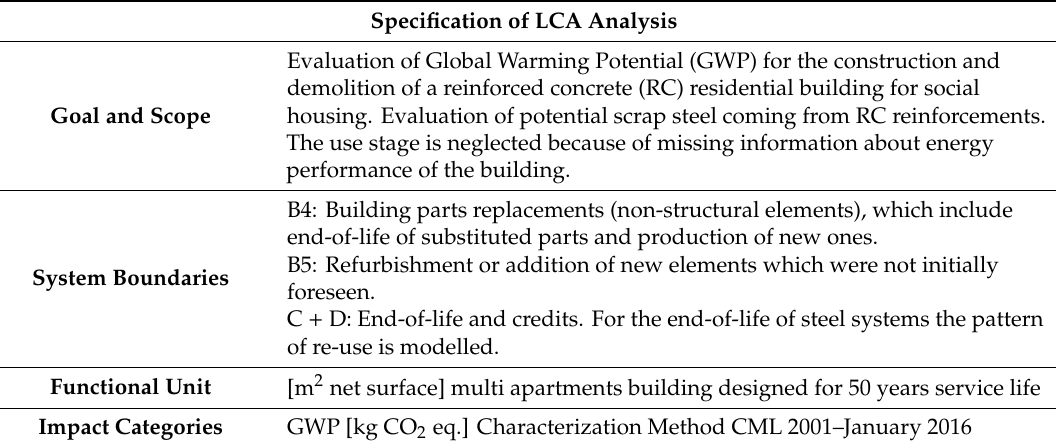
Table 1. Specification of life-cycle assessment (LCA) analysis according to